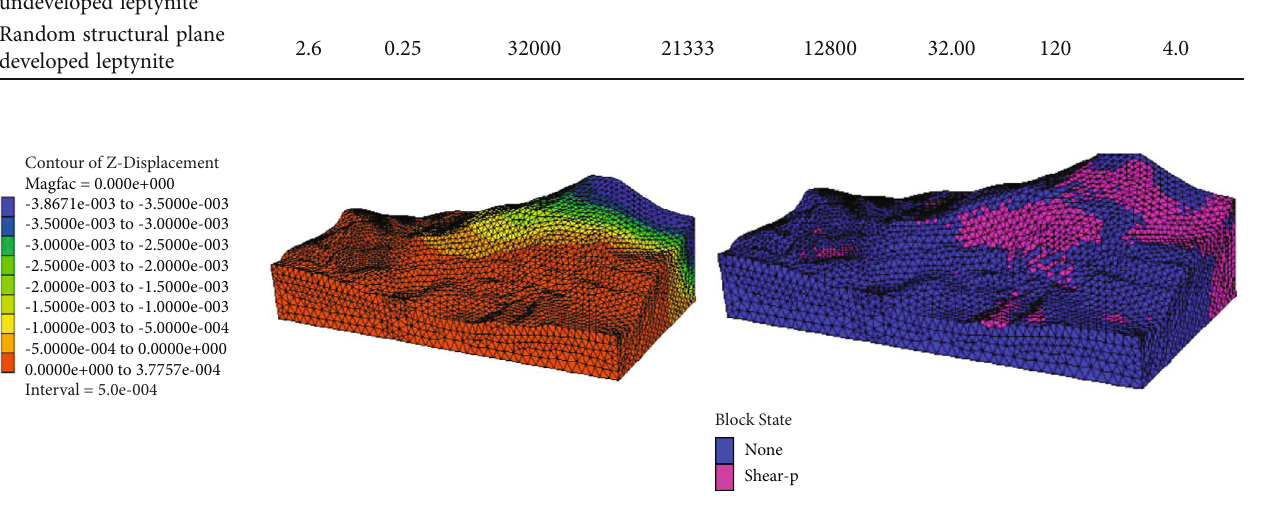
Figure 11: The cloud chart of maximum and minimum principal